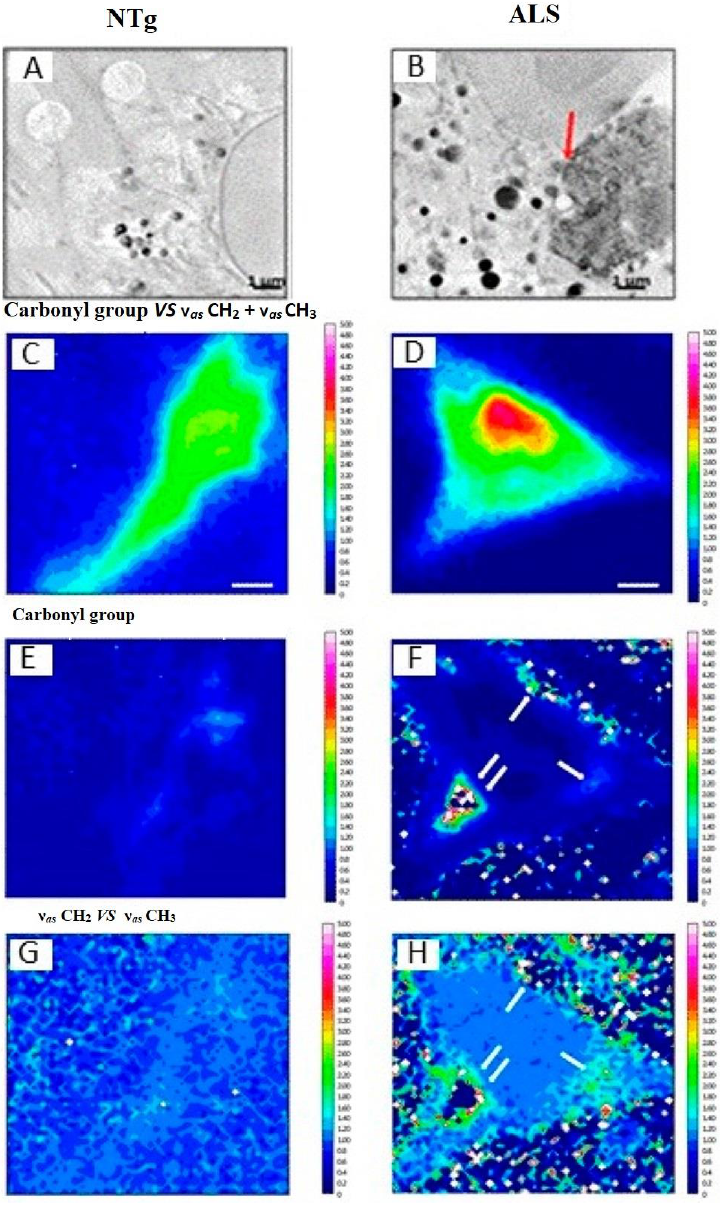
Figure 2. Synchrotron-FT-IR imaging of ( A ) Ntg and ( B ) ALS astrocytes, where ( C , D ) ν (C=O) vibrations, ( E , F ) ratio of ν (C=O)/( ν as CH 3 + ν as CH 2 ) vibrations, and ( G , H ) ratio of ν as CH 2 / ν as CH 3 vibrations reveal concentrated intracellular lipid compositions and acyl chain unsaturation (white arrows) associated with lipid vesicles and lipid peroxidation. Reproduced with permission from ref. [76,77]. Copyright 2019 American Chemical